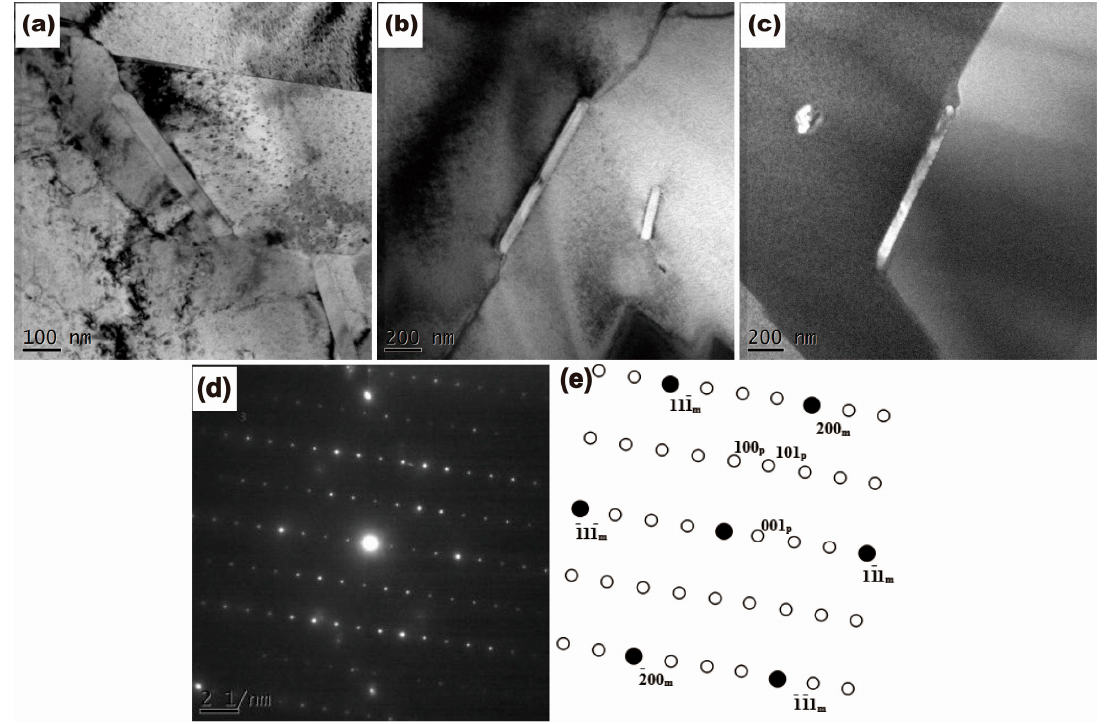
Figure 3. TEM images of Ni 3 Ti precipitates distributed in the grain boundary in 0.5% Ti alloys: ( a ) hot-extruded alloy; ( b ) solid solution alloy; ( c ) aged alloy; ( d ) SADP of the Ni 3 Ti phase in 0.5% Ti aged alloy; ( e ) Schematic of the SADP in (d).